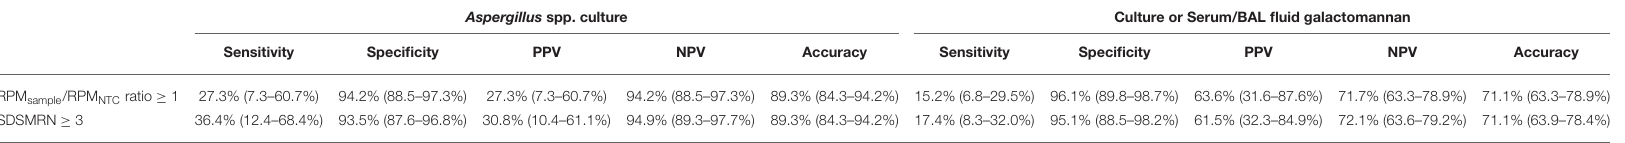
TABLE 3 | Diagnostic performance of metagenomic sequencing for invasive pulmonary aspergillosis.